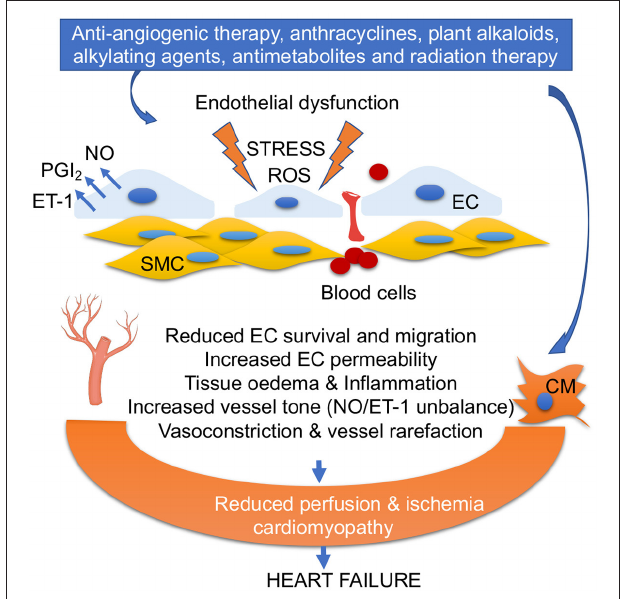
FIGURE 2 | Anticancer drug-mediated endothelial dysfunction. Oxidative stress, ROS accumulation, alteration of PGI 2 /ET-1 ratio, and low NO levels in ECs impair EC survival and migration, increase fenestration and blood cell infiltration into vascular smooth muscles (SMC), trigger inflammation, and promote vasoconstriction. EC dysfunction and vascular rarefaction reduce myocardial perfusion, leading ischemia, and cardiomyopathy. Anticancer drug-mediated cardiomyocyte (CM) damage together with EC dysfunction leads to heart failure.